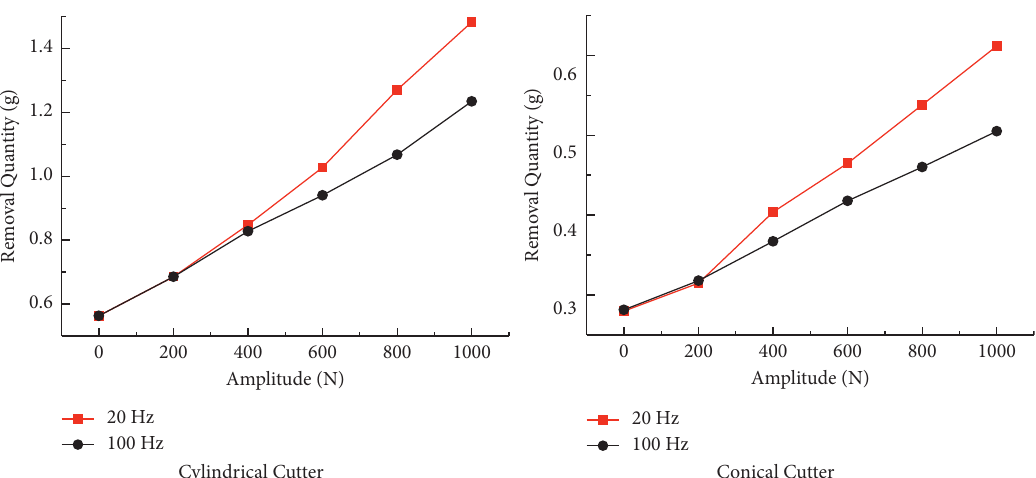
Figure 10: The effect of impact amplitude on removal